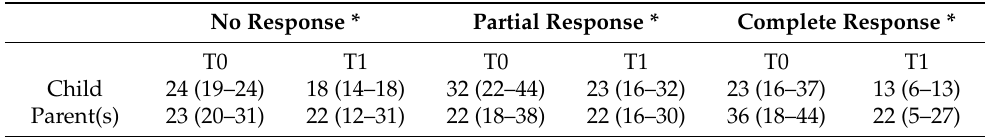
Table 3. Disease-specific quality of life on the pediatric incontinence questionnaire (PIN-Q), subdi- vided for treatment outcome (Median/25th–75th